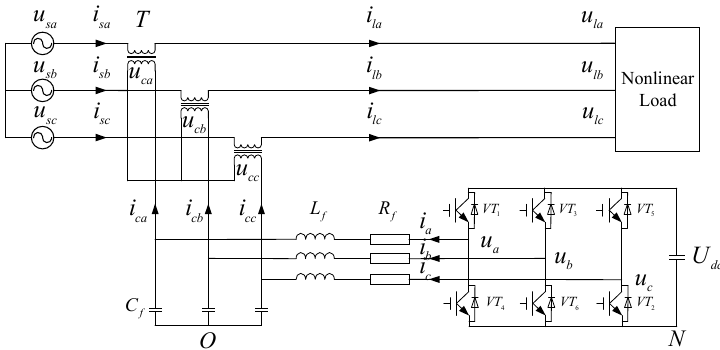
Figure 1. Three-phase two-level SAPF topology.